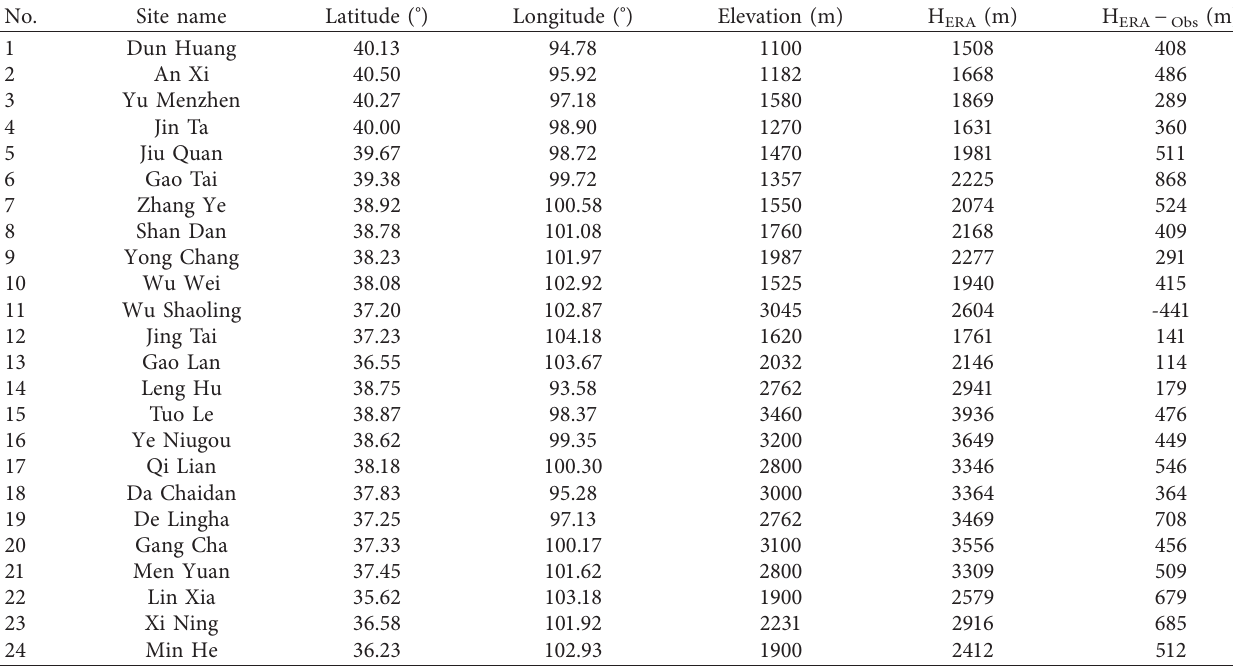
Table 1: Meteorological station information.